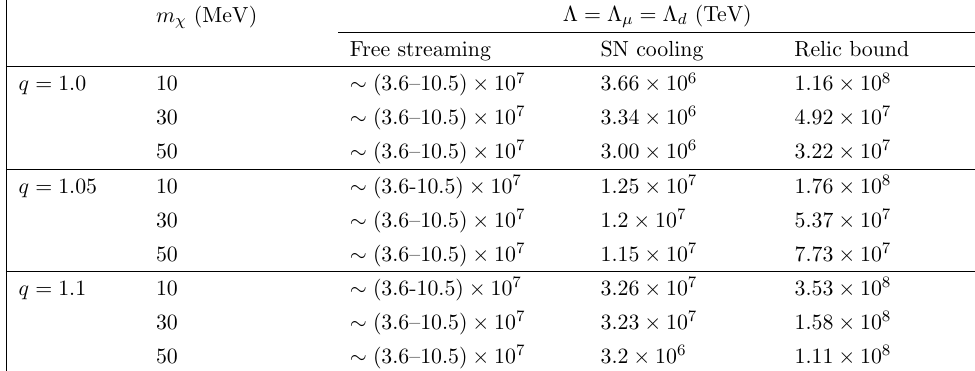
Table 1 . The bound on the e(cid:11)ective scale (cid:3) = (cid:3) (cid:22) = (cid:3) d (TeV) (lower bound obtained from optical depth criterion, Ra(cid:11)elt’s criteria and upper bound obtained from relic density experimental value) are shown for di(cid:11)erent dark matter mass m (cid:31) (MeV) in the undeformed ( q = 1) and q -deformed scenario, for free streaming (optical depth criterion) there is a range of the reported value [7] as it depends on the other supernova properties like temperature, densities etc.